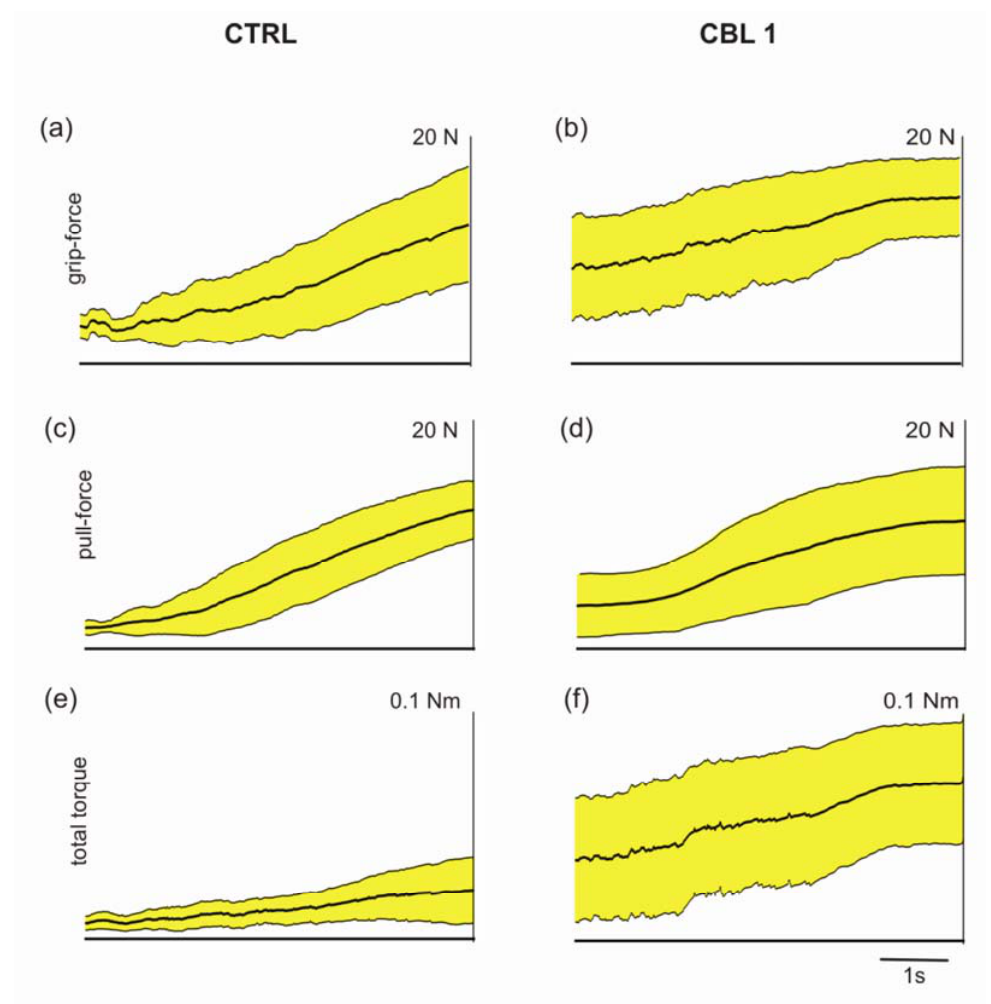
Figure 5. Averaged responses of grip force, pull force and torque of the healthy subject (CTRL) and the cerebellar patient (CBL1). (a, b) Averaged total grip force (thick black line) ± standard deviation (yellow area) (c, d) Averaged total pull force ± standard deviation. (e, f) Averaged total torque ± standard deviation. All recordings are aligned to the unpredictable rod